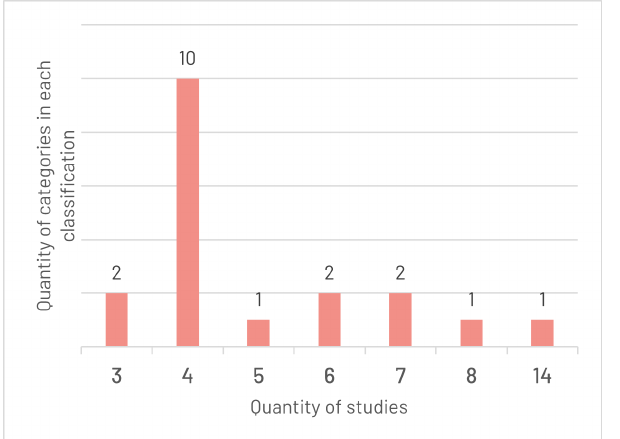
Figure 8. Game genres covered by the classifications Calegari and Celino (2018) work with GWAPs, which may have varied purposes within the spectrum of games that aim to get player collaboration on something.